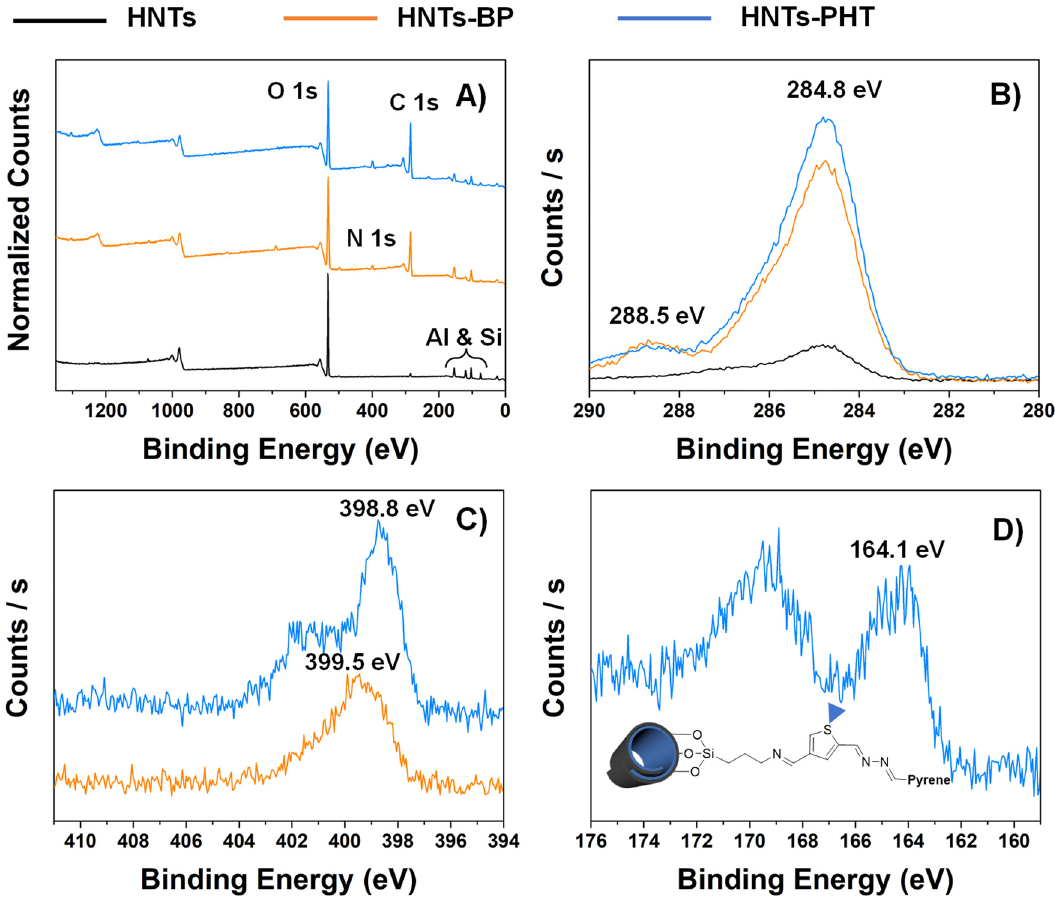
Figure 2: XPS studies [( a ) XPS curves of HNTs, HNTs - PHT and HNTs - BP; ( b ) C 1s regions of HNTs - PHT and HNTs - BP; ( c ) N 1s regions of HNTs - PHT and HNTs - BP; and ( d ) S 2p regions of HNTs - PHT ] .